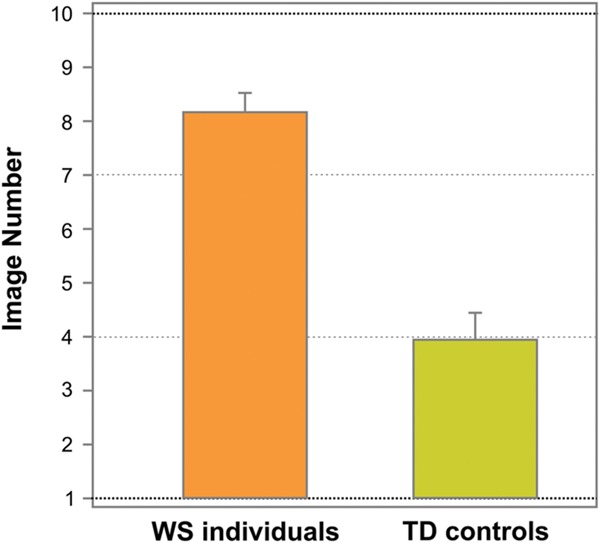
Tuning to faces. The average image number, on which resembling a face on the Face-n-Food task (face response) was initially reported, separately for WS and TD individuals. WS individuals experience much more troubles in spontaneous recognition of the images as a face. Vertical bars represent SEM.